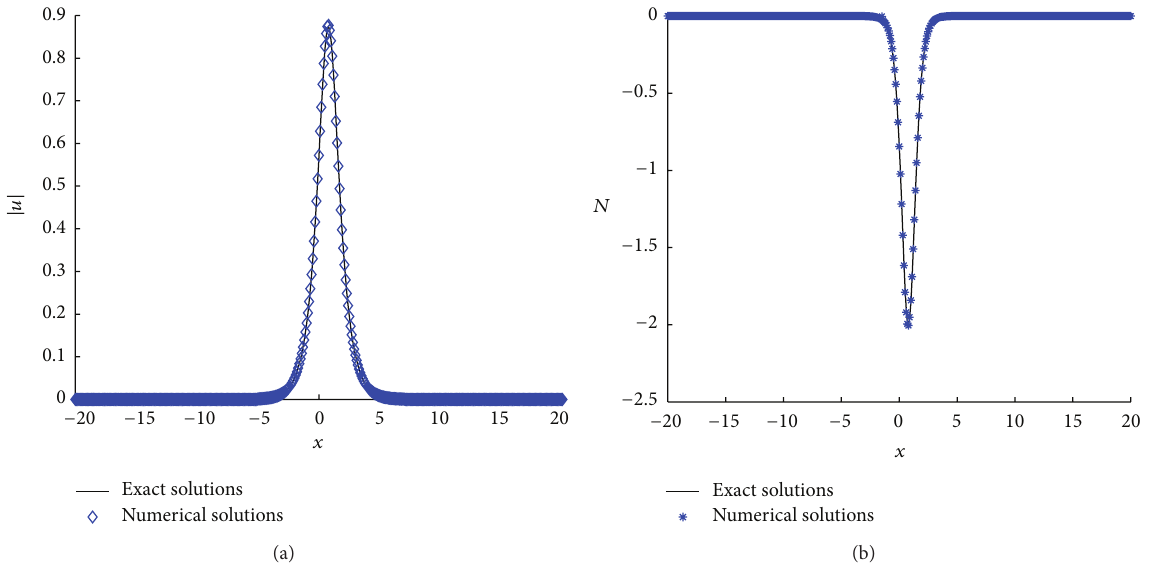
Figure 1: |𝑈| and 𝑁 computed by Scheme A with ℎ = 𝜏 = 0.1. Comparison between analytic solution and numerical solution at time 𝑇 = 1 .